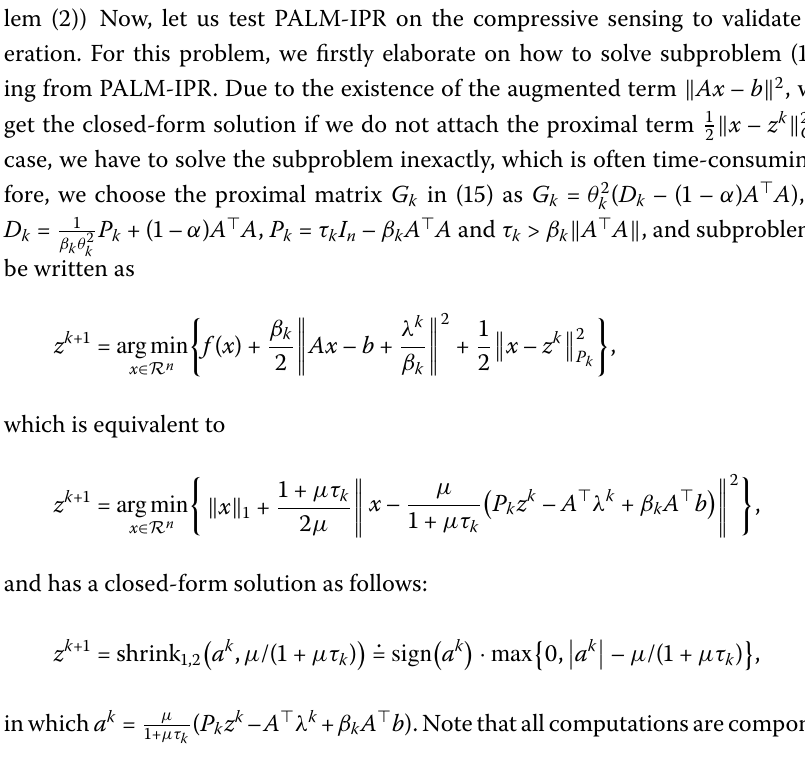
Table 1 Comparison of PALM-IPR with ALM